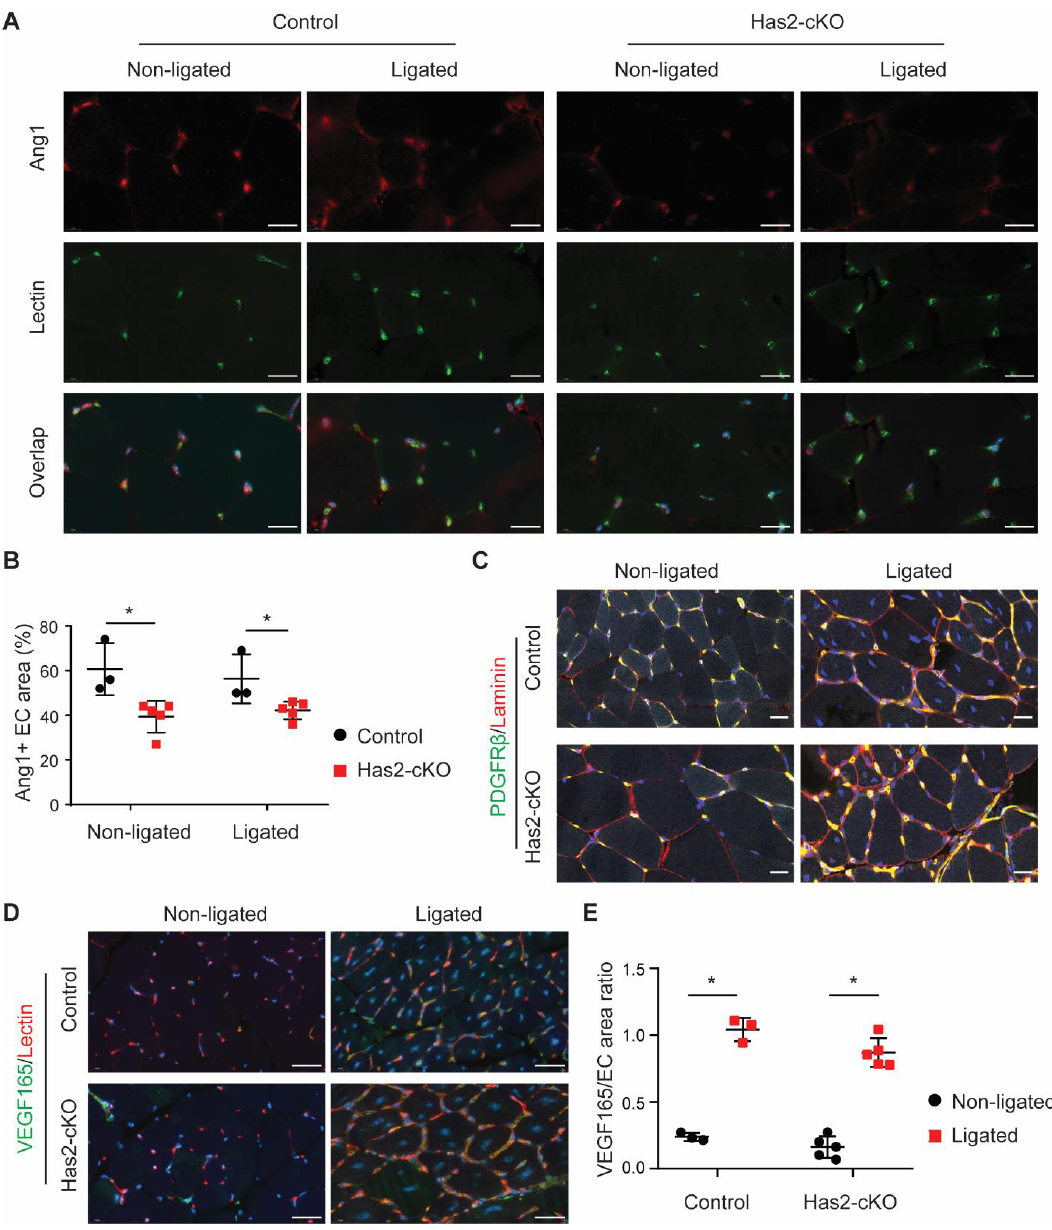
Figure 3. Loss of hyaluronan in ECs decreases angiopoietin 1 presence in ECs. ( A ) Representative images of angiopoietin 1 (Ang1, top) staining and BS1-lectin staining (middle) for ECs